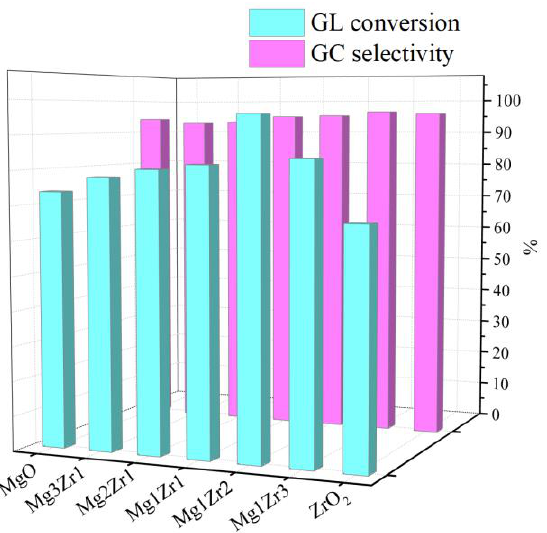
Figure 6. Catalytic performance of Mg-Zr oxides for transesterification of GL with DMC to GC (Reaction conditions: GL/DMC molar ratio = 1/5, catalyst loading = 3 wt% of GL, 90 °C, 60 min).